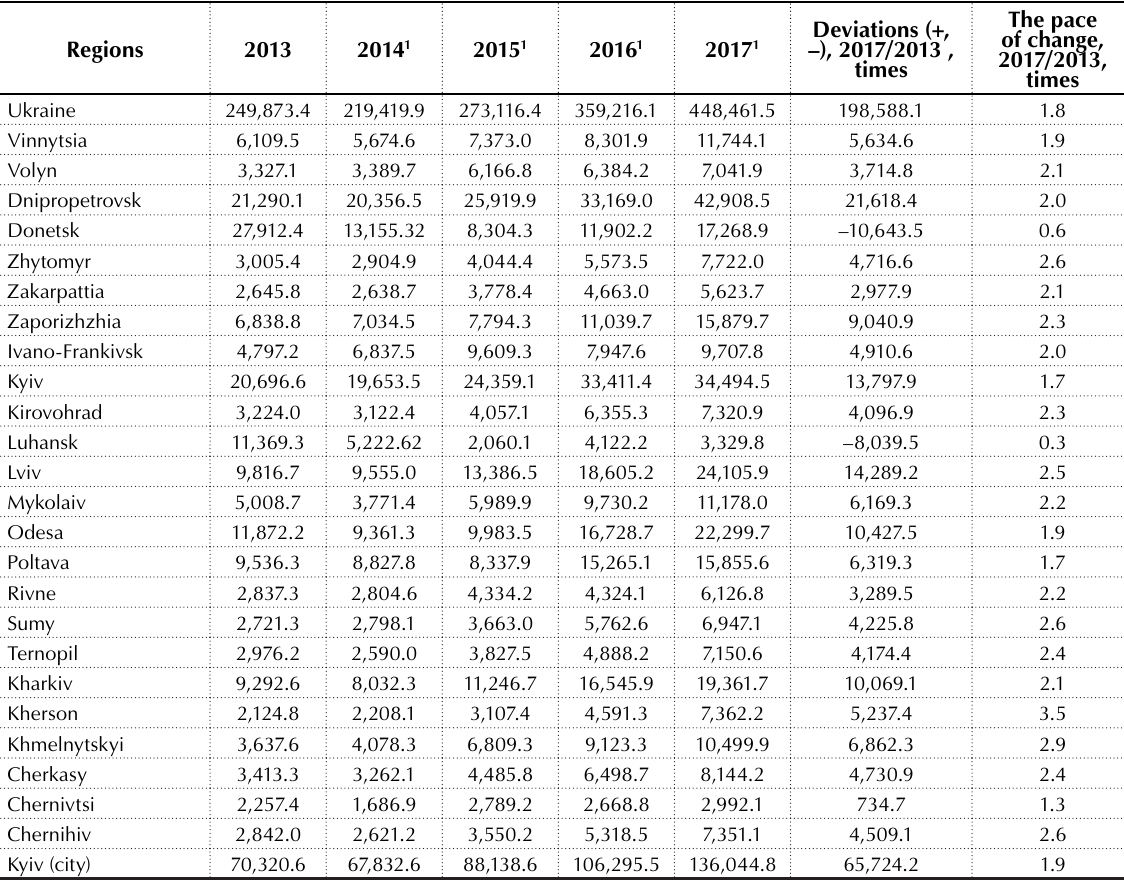
Table 6. Dynamics of capital investments by regions for 2010–2017 Source: Державна служба статистики України [Derzhavna sluzhba statystyky Ukrainy]